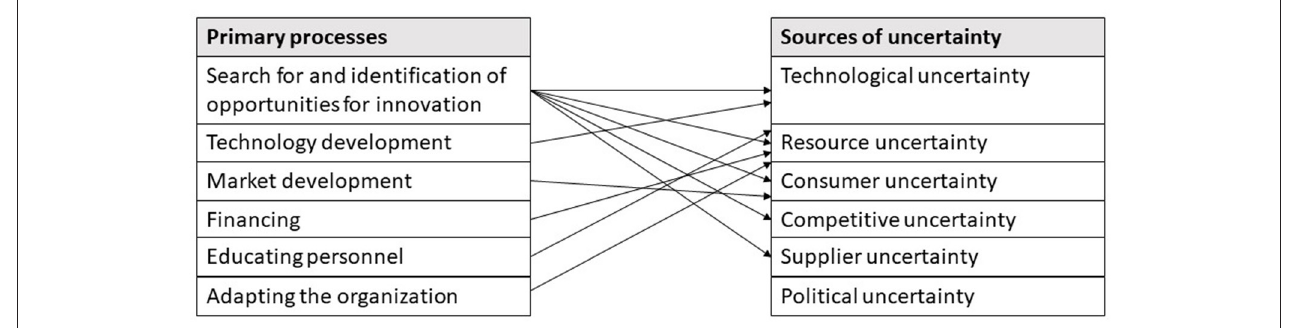
FIGURE 1 | How the primary processes are linked to six sources of uncertainty (adapted from Meijer et al., 2006).